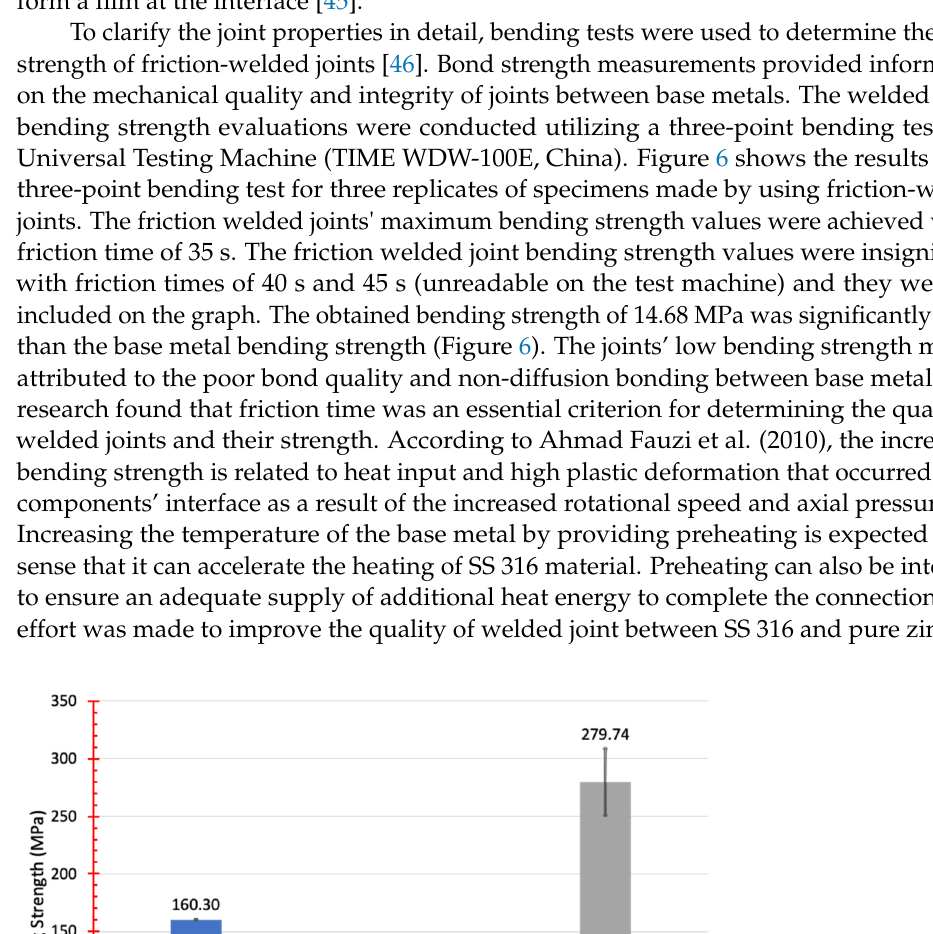
7 of 14 Figure 5. Tensile strength of SS 316-pure Zn joints rotary friction-welding (friction time of 35 s, 40 s, 45 s, 35 s—100 °C, 35 s—150 °C, and 35 s—200 °C, rotation speed at 1450 rpm, friction pressure at